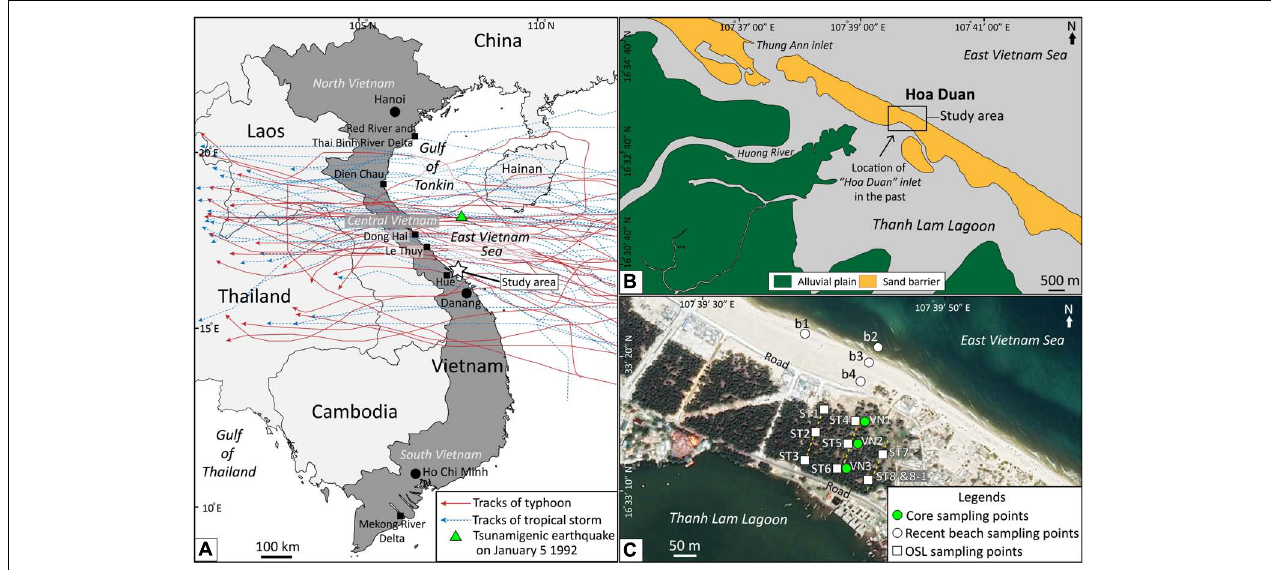
FIGURE 1 | The study site at Hoa Duan, Thua Thein Hua, Central Vietnam. (A) Vietnam with tracks of major tropical storms and typhoons from 1952 to 2019, which mostly moved from east to west. Note that the tracks of tropical storms and typhoons are listed only for those in central Vietnam and are presented in Supplementary Table 2 . (B) A geomorphological map of the study site showing the sand barriers, lagoons, alluvial plains, Thuan An inlet, and old Hoa Duan inlet (which was permanently closed), and (C) a close up satellite image from Google Earth of the Hoa Duan barrier showing the sampling points of core samples, OSL dating, and recent shore-normal beach